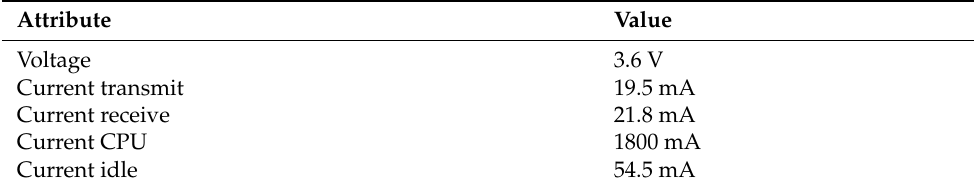
Table 4. Sky Mote power specifications.